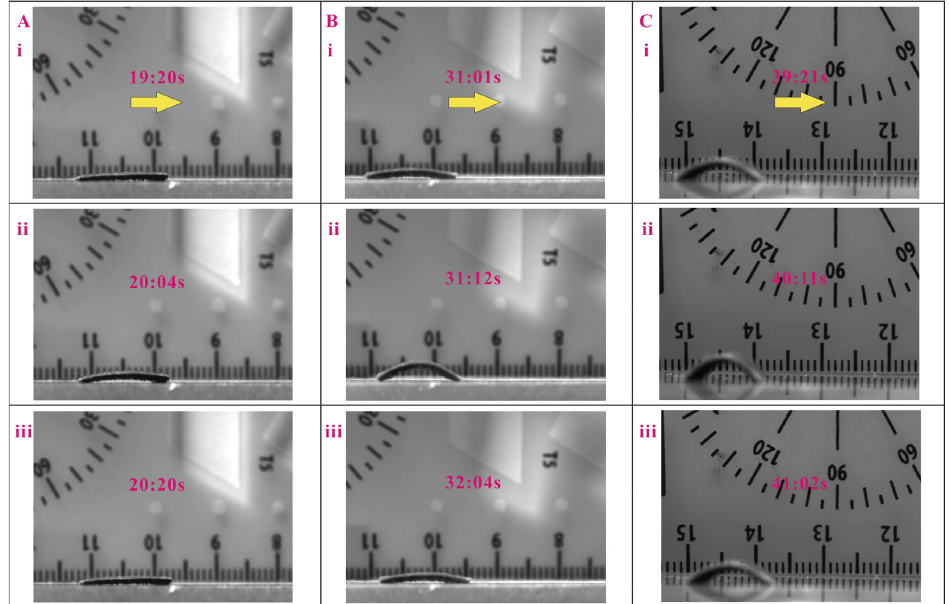
Figure 4. Locomotion test results of magnetic inchworm robots with 200 µm micropillars. ( A ) Stretched length is 1 mm, and the step size is about 0.33 mm. ( B ) Stretched length is 1.25 mm, and the step size is about 1.25 mm. ( C ) Stretched length is 1.5 mm, and the step size is about 0.83 mm. In each subfigure, the yellow arrow represents the movement direction. i, ii, and iii indicate the snapshots at different times.